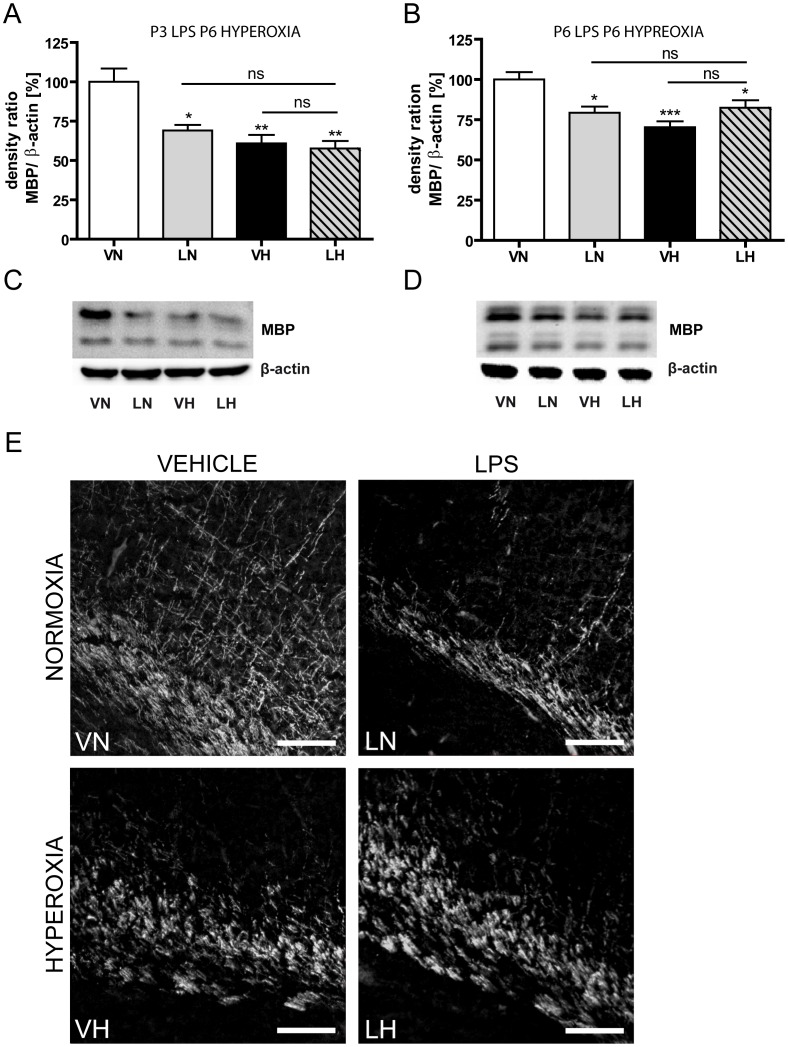
Inflammation and hyperoxia decreases MBP expression.A significantly decrease of MBP protein expression as a sign of hypomyelination occurs in all experimental settings with similar severity. Results of densitometric western blot quantification of P3 LPS P6 hyperoxia experiment (A), results of densitometric western blot quantification of P6 LPS P6 hyperoxia experiment (B), a representative western blot series of P3 LPS P6 hyperoxia experiment (C), a representative western blot series of P3 LPS P6 hyperoxia experiment (D) and images of immunohistological stained sections against MBP (E) are shown. Immunohistological staining against MBP supports these findings and illustrates a profound reduction of MBP in external capsule with loss of processes and thinning up to fragmentation of the capsule in all treated groups. Scale bar = 100 µm. Brain hemisphere extracts were used for western blot analyses with n = 9–11 animals per group. Western blot values represent mean+SEM normalized ratios of the MBP bands to β-actin as an internal standard and VN group was set to 100%. * p<0.05, ** p<0.01, *** p<0.001 and ns p>0.05; VN: vehicle+normoxia, LN: LPS+normoxia, VH: vehicle+hyperoxia, LH: LPS+hyperoxia.